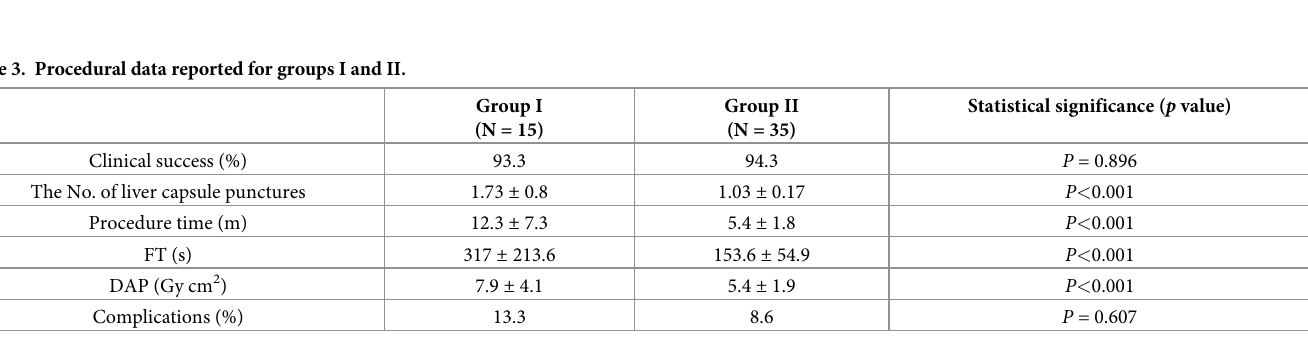
Table 3. Procedural data reported for groups I and